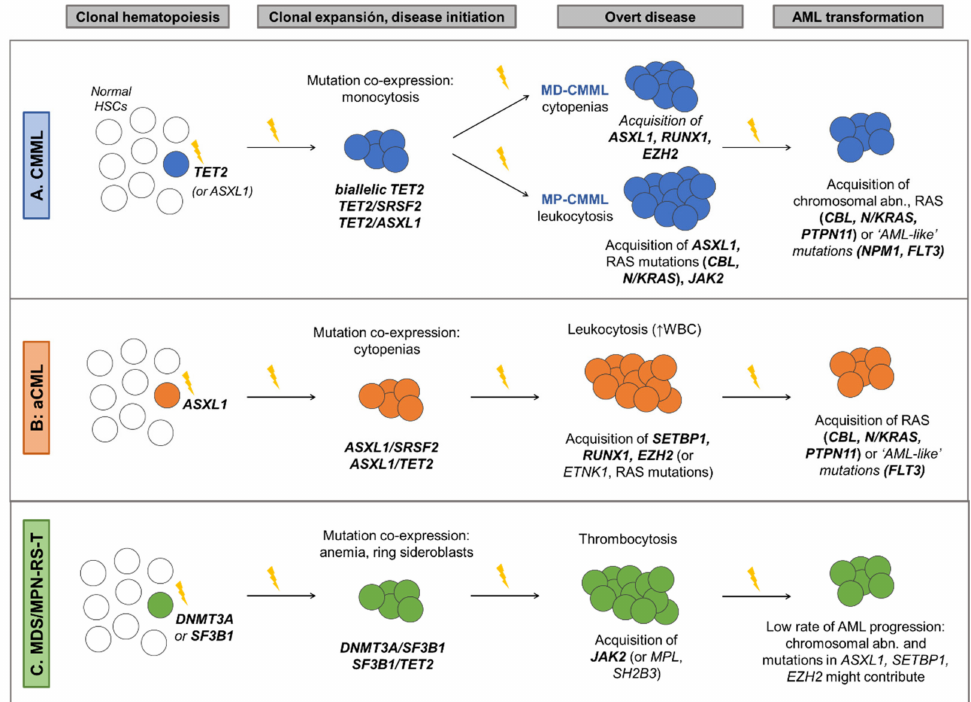
Figure 3. Clonal evolution model in adult MDS/MPN. The figure depicts the clonal evolution patterns most frequently observed in CMML ( A ), aCML ( B ) and MDS/MPN-RS-T ( C ). MDS/MPN arise from asymptomatic clonal hematopoiesis. Over time there is clonal expansion that leads to MDS/MPN phenotype and overt disease that, in some cases, even- tually progresses to AML. This process takes place through the acquisition of molecular hits (chromosomal abnor- malities and gene mutations) that confer to the neoplastic clone a selective advantage. The type of mutations and the order in which they are acquired shapes the disease phenotype and influences the clinical outcome. Based on data from Itzykson et al. [2], Palomo et al. [4], Elena et al. [30], Patnaik et al. [31], Coltro et al. [32], Palomo et al. [33], Meggendorfer et al. [35], Patnaik et al. [26], Steensma et al. [49], Itzykson et al. [50], Ricci et al. [51], Mason et al. [52], Awada et al. [53] and Patel et al. [54]. Abbreviations: aCML: atypical chronic myeloid leukemia; AML: acute myeloid